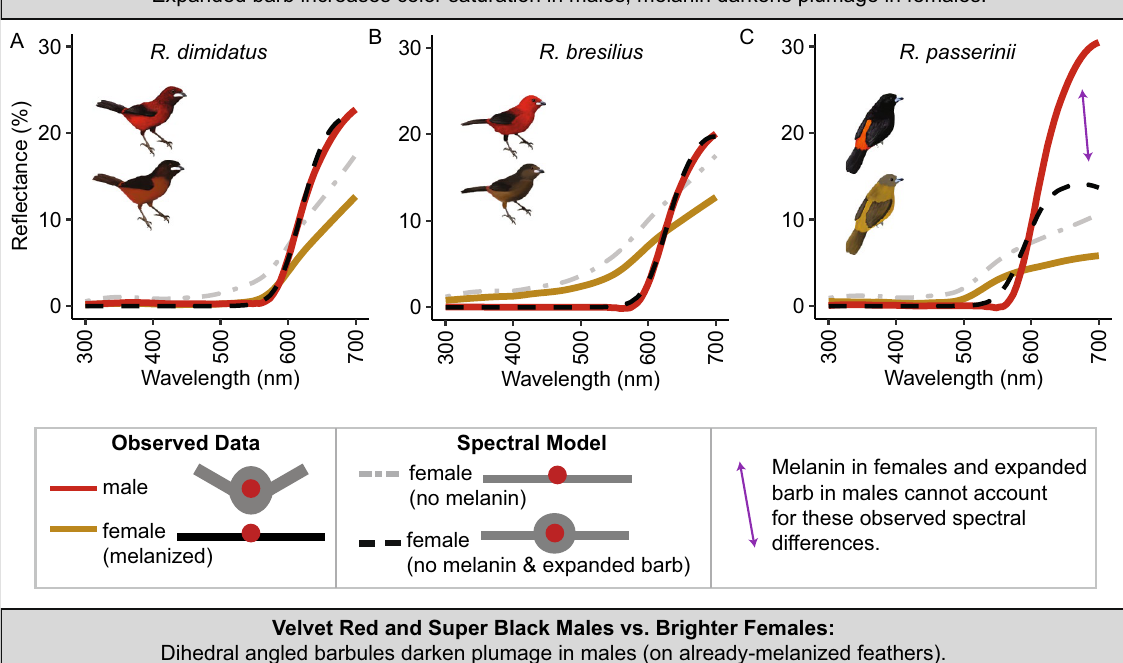
Colorful Males vs. Duller, Browner Females: Expanded barb increases color saturation in males, melanin darkens plumage in females.